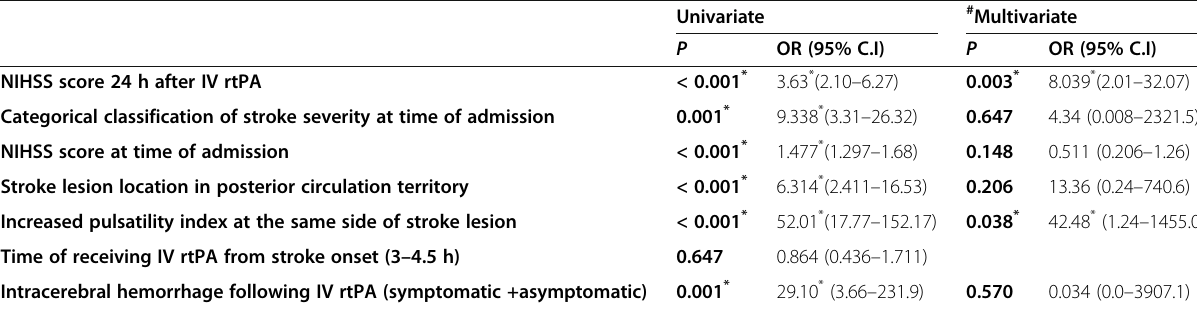
Table 4 Univariate and multivariate analysis between study variable (stroke illness and ICH following IV rtPA) and poor functional outcome